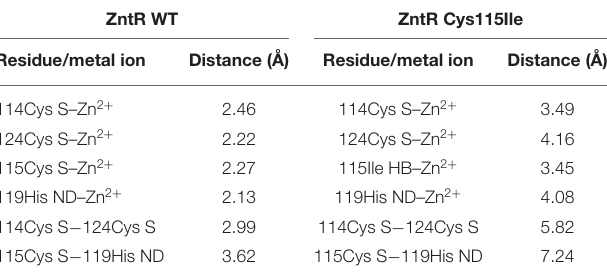
TABLE 2 | Distances between the metal ions and residues located at the metal-binding loops of ZntR wild-type (WT) and Cys115Ile mutant measured from the model